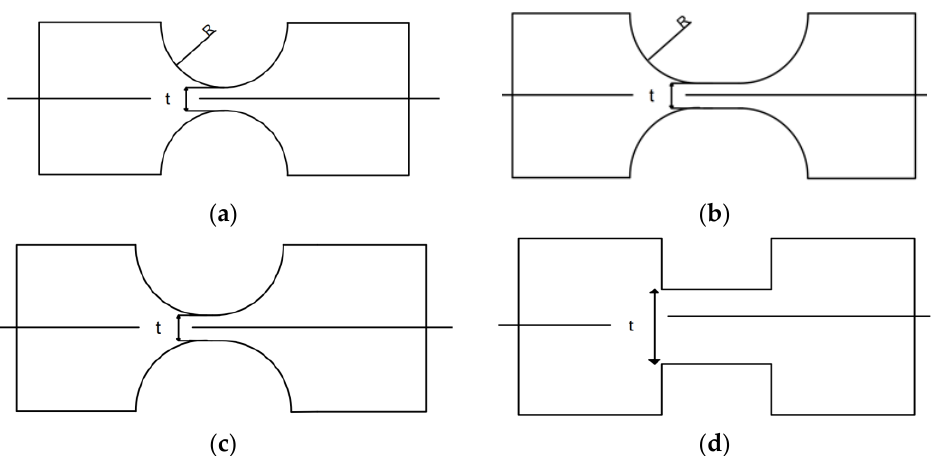
Figure 5. Flexure hinge with different shapes: ( a ) straight circular flexure; ( b ) circular flexure hinge; ( c ) parabolic flexure hinge; ( d ) straight beam flexure. Table 2. Material parameters of flexure